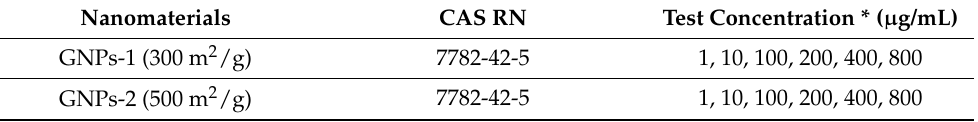
Table 1. Test concentration of the two different carbon nanomaterials.